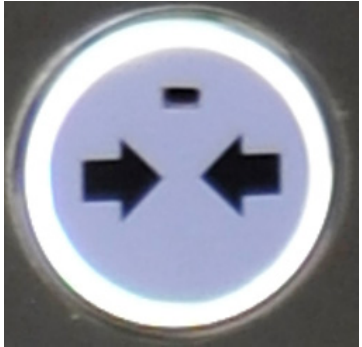
Figure 9. Contact-free perceptual button.